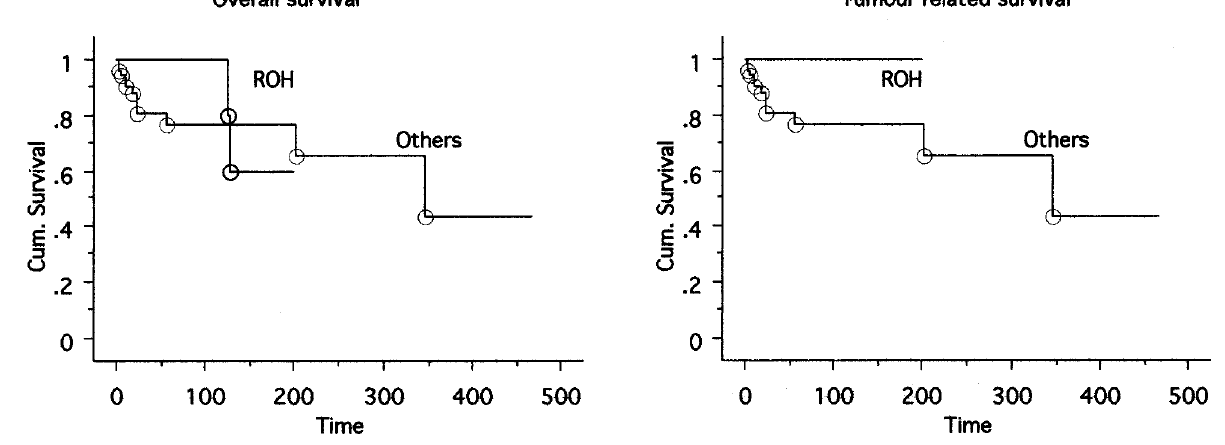
Fig. 4. Survival from periosteal osteosarcoma. (a) Overall survival for 66 patients with published data. No deaths after 120 months were due to the primary tumour. (b) Tumour-free survival from diagnosis comparing this series with data from all previous published